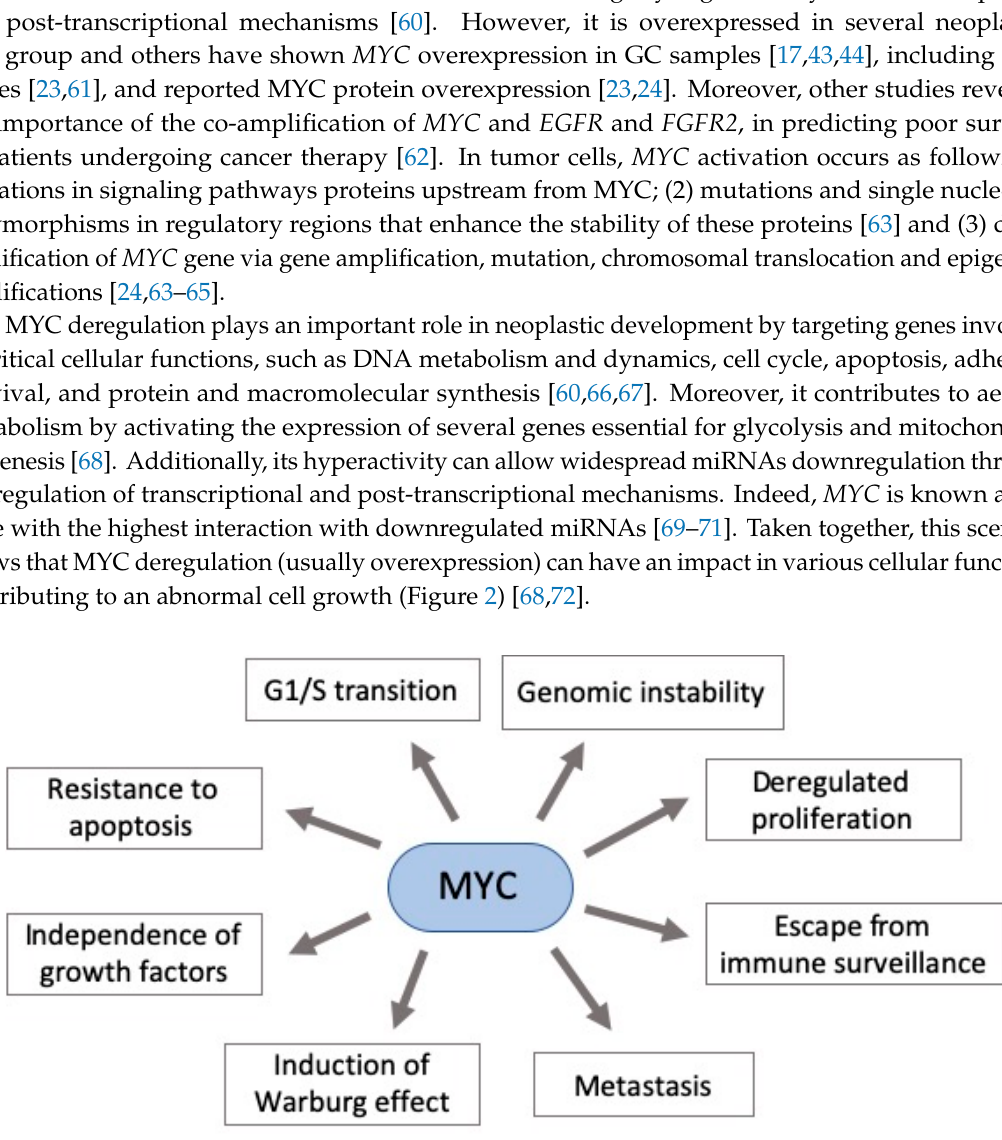
Figure 2. Pleiotropic consequence of MYC deregulation in cancer. MYC overexpression in gastric carcinogenesis affects various components of signaling pathways critical to cancer establishment. Some of these pathways’ phenotypes are shown here.